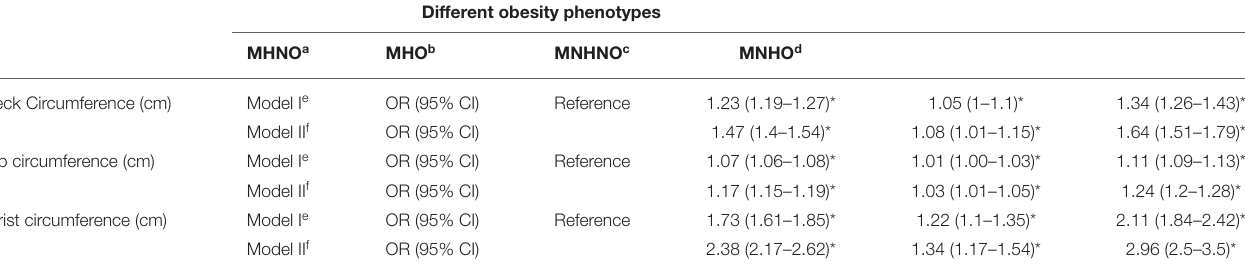
TABLE 5 | Association of neck, hip, and wrist circumference with metabolic status in a multinomial logistic regression